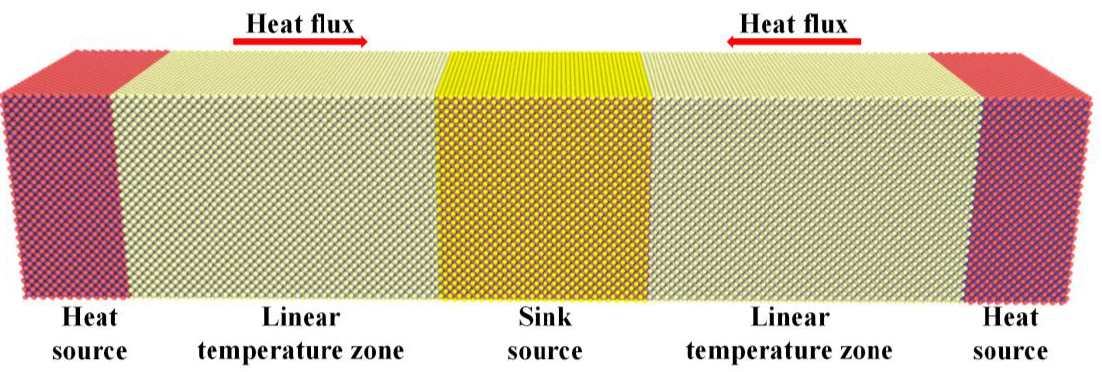
Figure 2. The typical thermal conductivity calculation model of SiC [28].